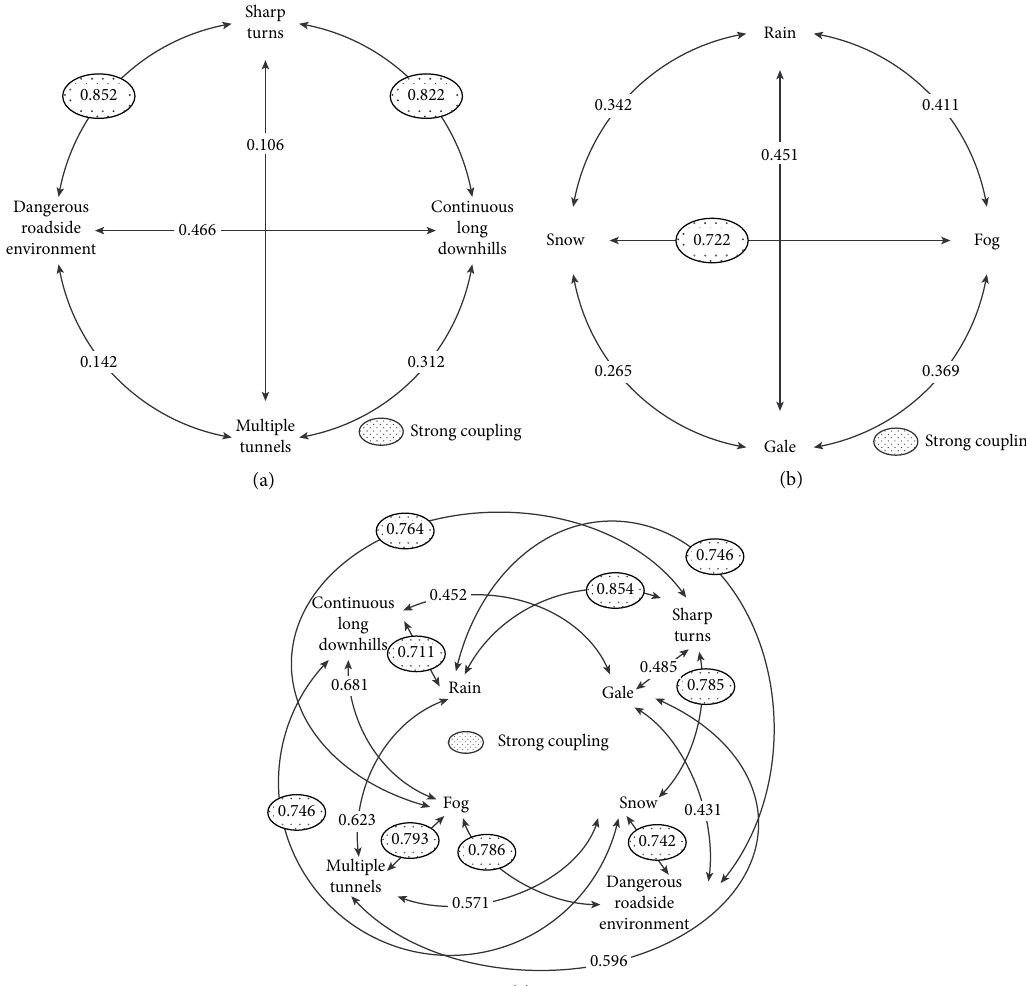
Figure 2: Distribution of coupling degrees of two factors coupling effects among risk